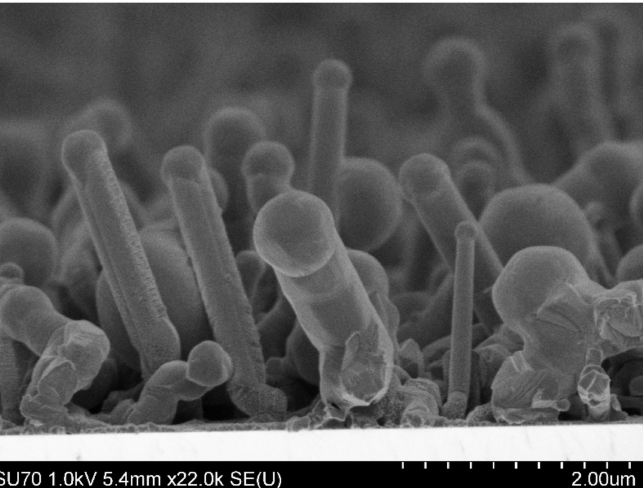
Figure 2. SEM image showing a profile of InN nanocolumns growing upward toward the plasma source shown schematically in Figure 1. Droplets of indium metal are at the tops of nanocolumns, the indium having migrated upwards due to the electric fields